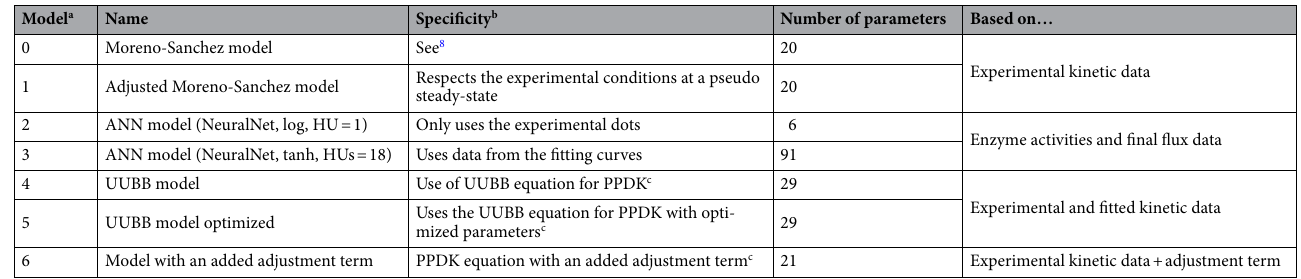
Table 5. List of the main properties of each model. a Only the best models from each approach are kept. b For a complete description of the modeling process, see the “Methodology” section. c Respect of pseudo steady-state experimental conditions.